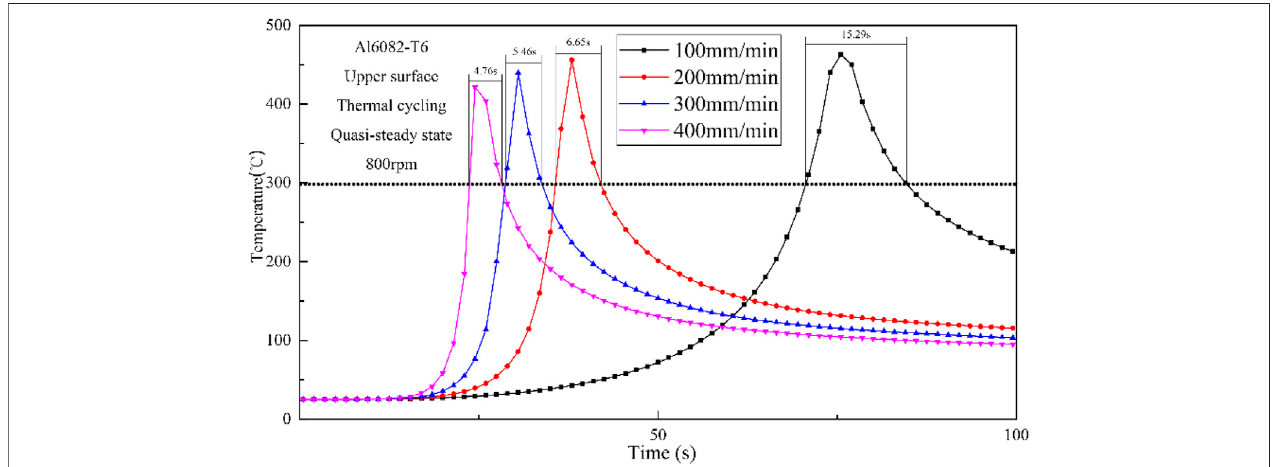
FIGURE 16 | Thermal cycle curves of feature points under different travel speeds.